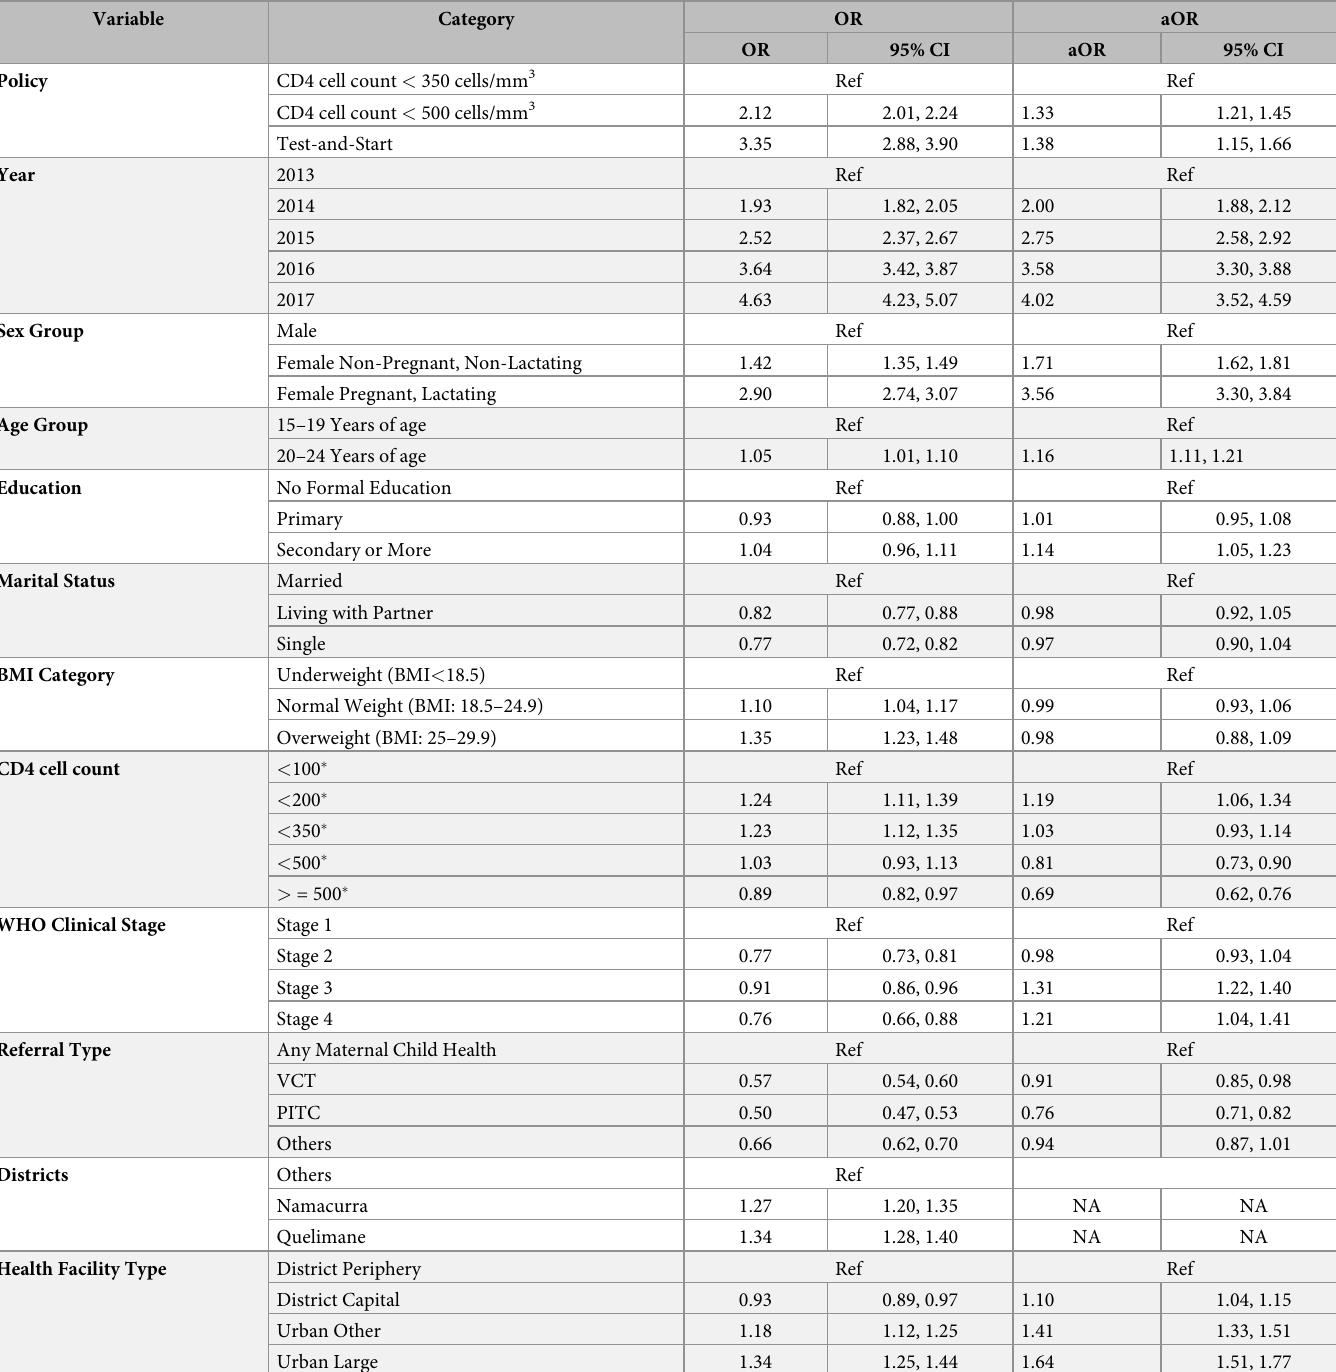
Table 3. Odds of being retained in care before ART initiation + .